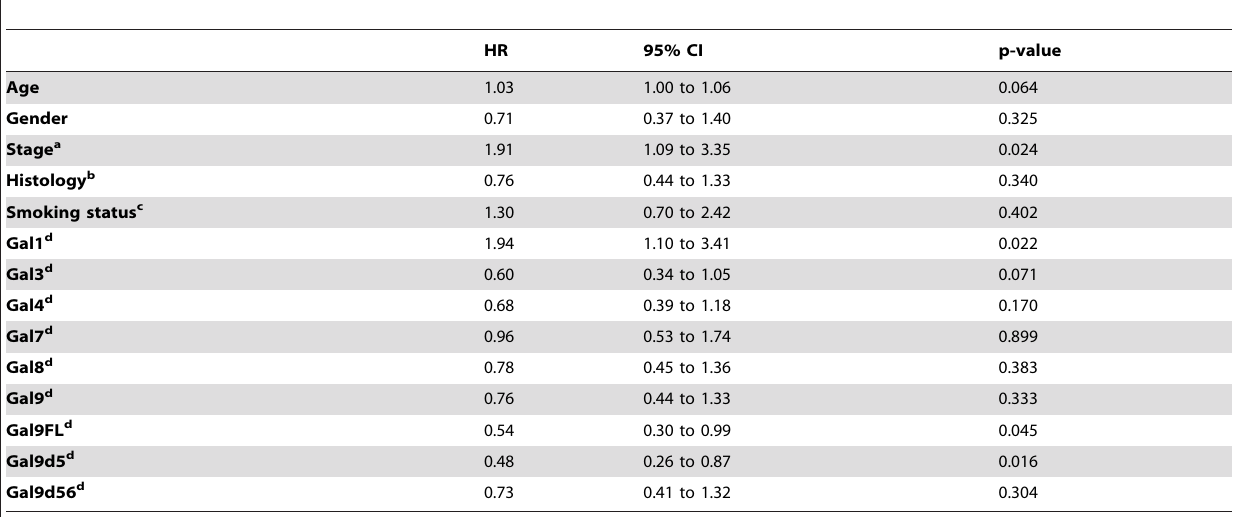
Table 2. Univariable analyses of standard clinical variables and galectin mRNA expression levels in relation to overall survival in 87 patients with early stage NSCLC.